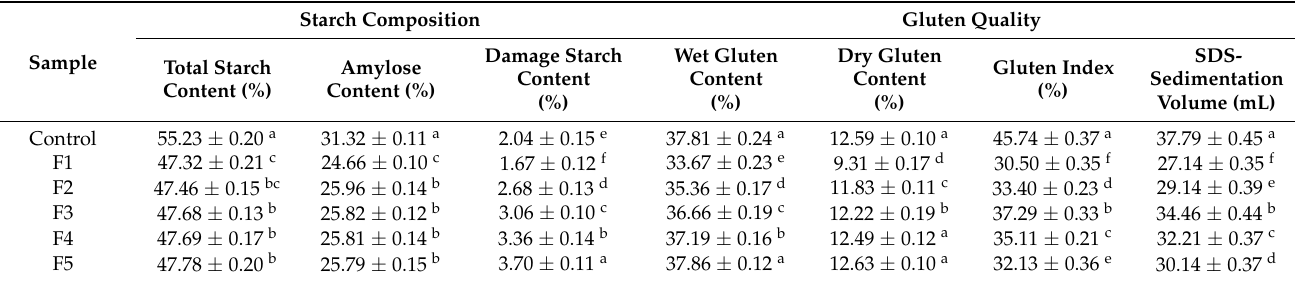
Table 1. Starch composition and gluten quality of wheat